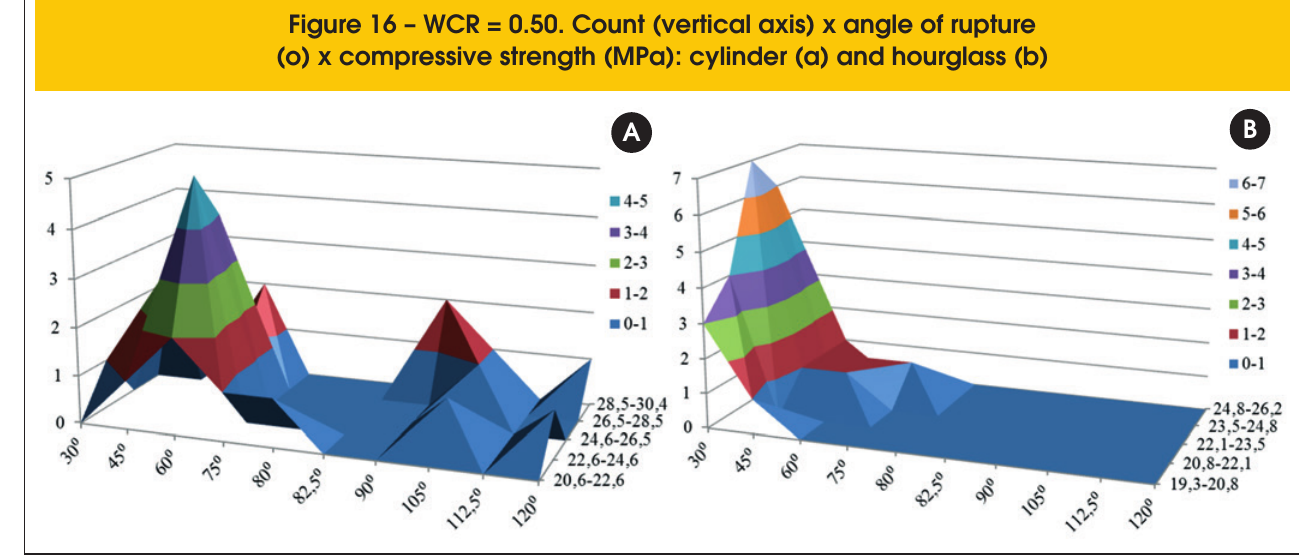
Figure 16 – WCR = 0.50. Count (vertical axis) x angle of rupture (o) x compressive strength (MPa): cylinder (a) and hourglass